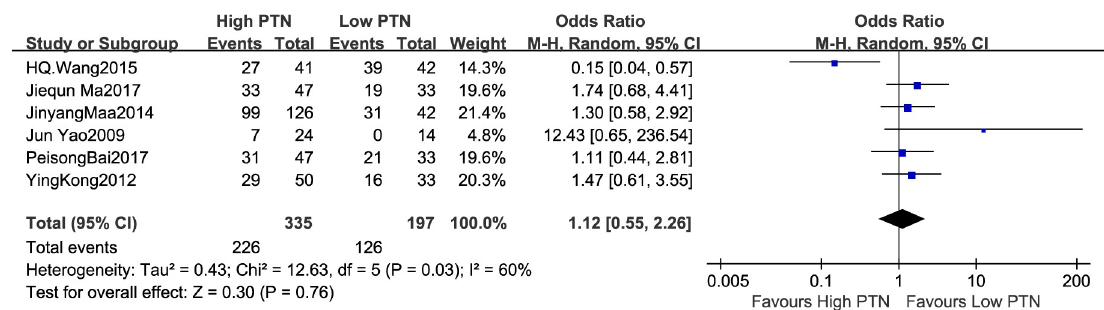
Fig 2. A forest plot for the association between the PTN expression levels with tumour size. The tumor size was not markedly increased in the high PTN expression group compared with the low PTN expression group.